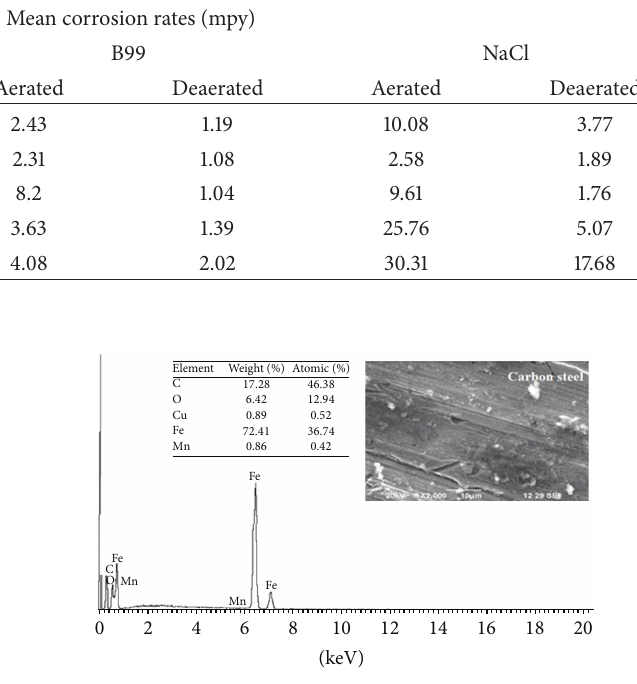
Figure 6: SEM image and EDS spectra of carbon steel sample immersed in